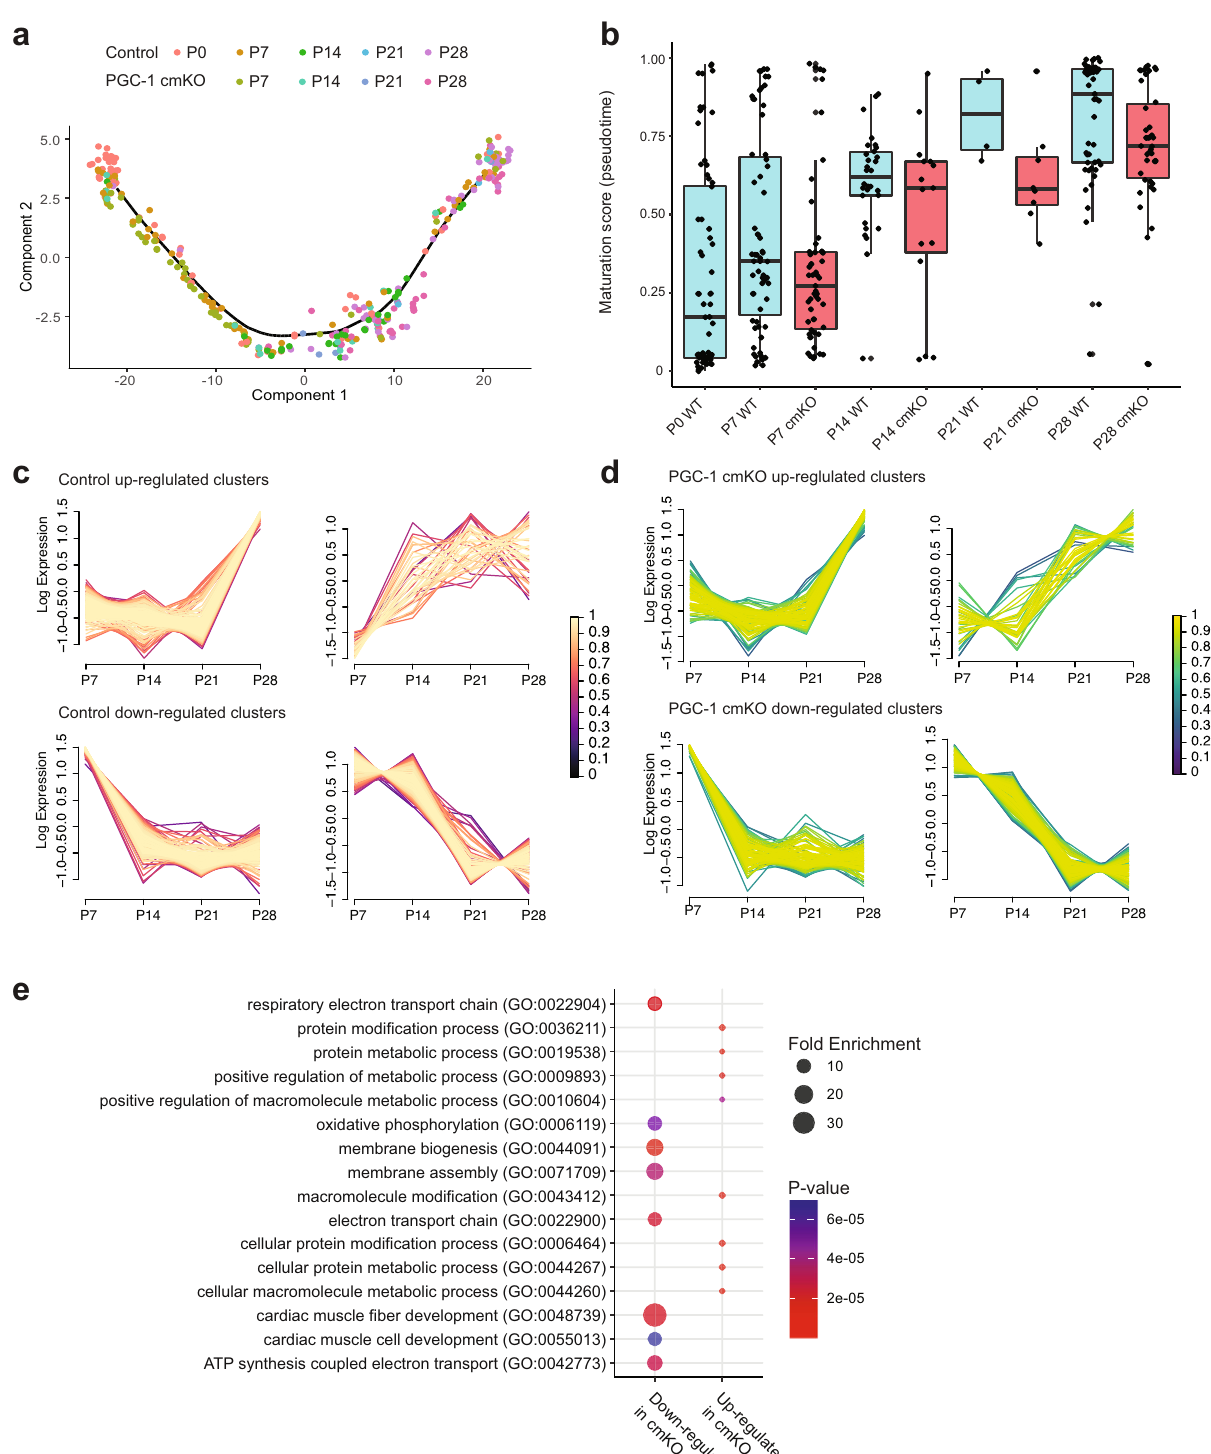
Fig. 4 PGC1-de fi ciency leads to maturation defects in postnatal CMs and affects gene regulatory networks controlling muscle development and mitochondrial process. a Single-cell transcriptomic trajectory of control and PGC1 cmKO CMs. 300 control and 328 cmKO CMs were used after quality cutoff. b Distribution of pseudotime maturation scores analyzed from p0 – p28. c Fuzzy clustering with selected clusters for upregulated (top) and downregulated (bottom) genes. Color indicates the membership score of each gene in the cluster. d Fuzzy clustering of PGC1 cmKO CMs showing upregulated (top) and downregulated (bottom) clusters. e GO term visualization by fold enrichment (dot size) and p -value (dot color). Box-and-whiskers plot represents the maxima, 75th percentile, median, 25th percentile, and minima.